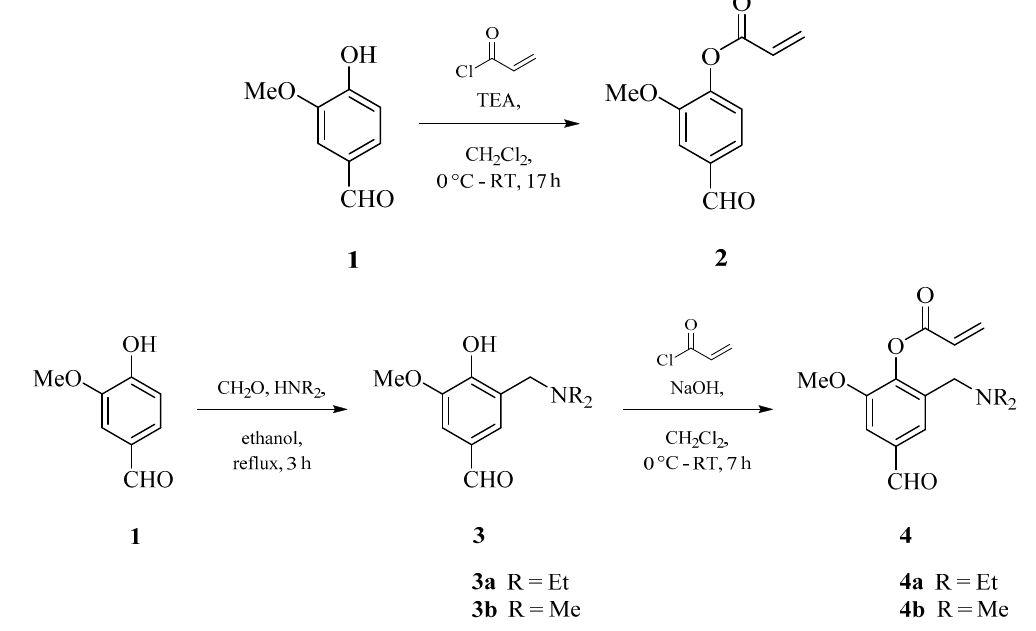
DM: DMAMVA); the first number denominates the feed content of the photo cross-linker, and the second number denominates the feed content of the vanillin derivative.